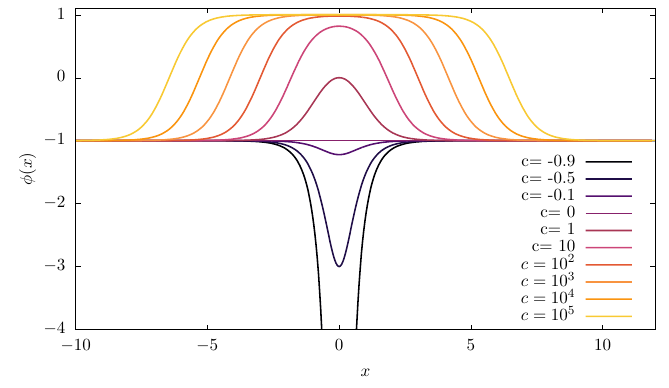
Figure 1 . Kink-antikink and bump solutions (cid:30)